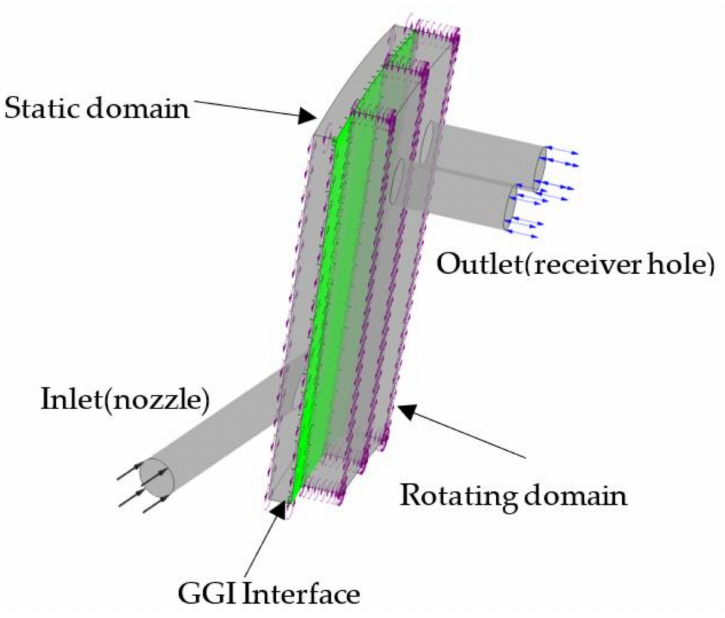
Figure 4. The computational model used in computational